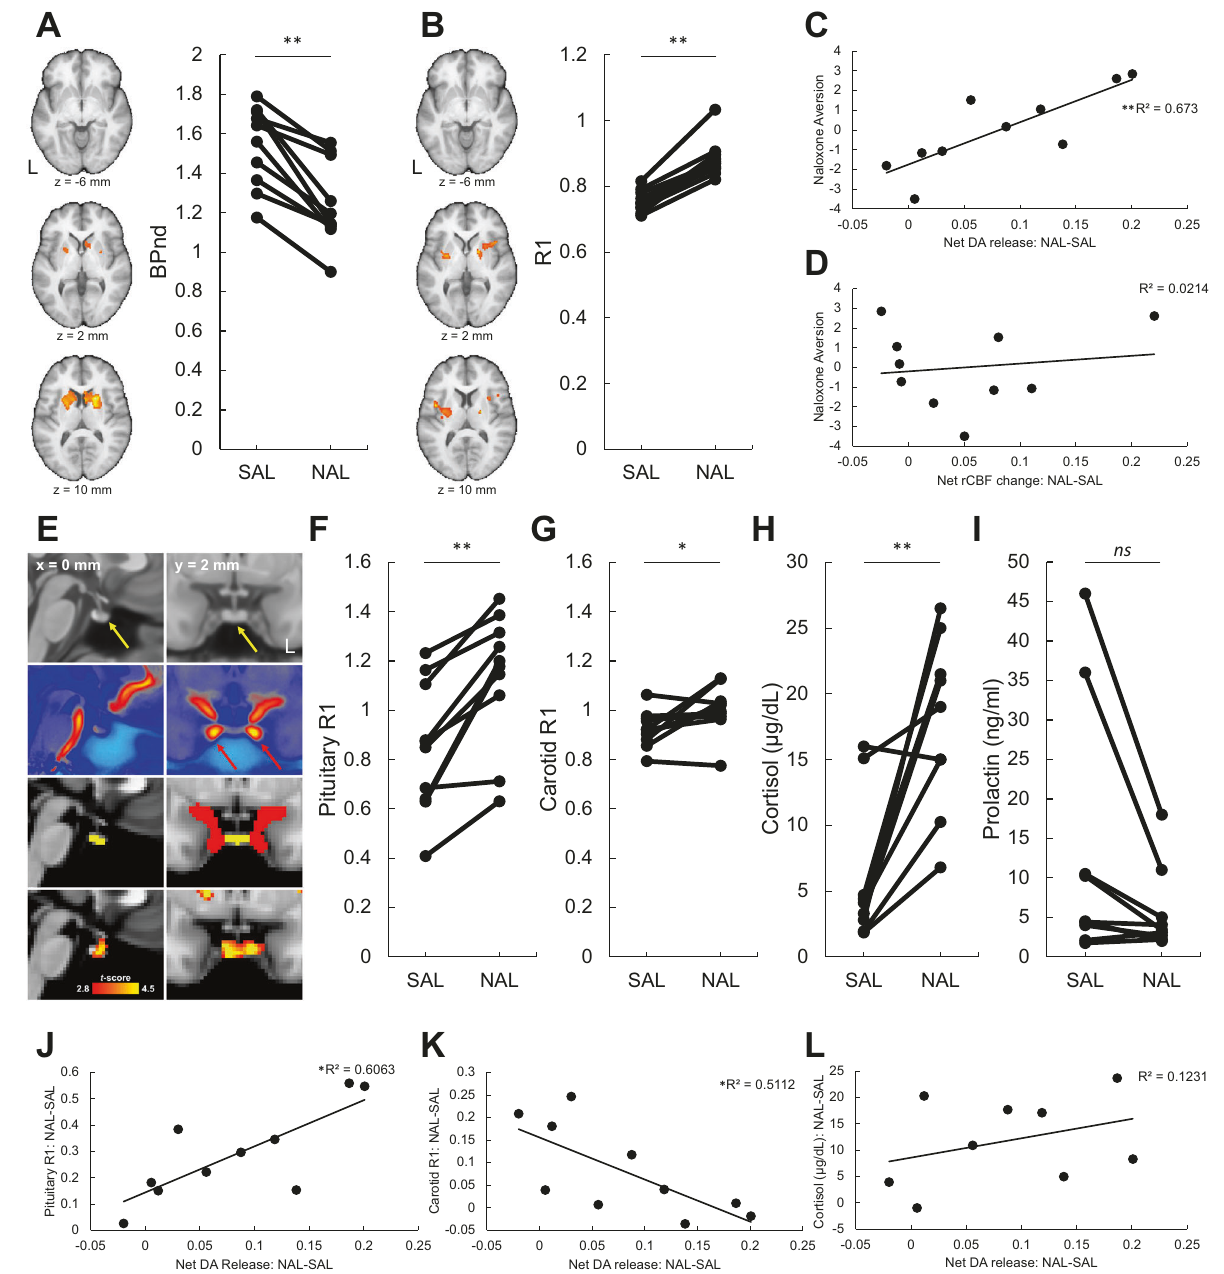
Fig. 1 Naloxone precipitated withdrawal affects dopamine release and relative cerebral blood fl ow in OUD men. A Voxelwise t -test on [ 11 C]racloprideBPnd revealed consistent decreases in NAL compared to SAL ( p FWE < 0.05). B Increases in R1 (a surrogate for rCBF) in the NAL compared to SAL ( p FWE < 0.05). C , D Index of naloxone aversion (higher component scores indicate more aversion) was signi fi cantly associated with net increases in striatal DA-release but not with net increases in striatal rCBF (see the “ Methods ” section). E Left and right columns show sagittal and axial views of the human brain. First row: T1w map of human brain (0.5-mm isotropic). The yellow arrows point at the pituitary. Second row: magnetic resonance angiography map of human brain (0.5-mm isotropic) [42]. The red arrows point at the internal carotid arteries. Third row: pituitary (yellow) and internal carotid arteries (red) ROIs. Fourth row: map of t -scores for the effect of NPW on R1 (cluster size > 200 voxels). F Increases in pituitary R1 across participants with NAL compared to SAL. G Increases in carotid R1 with NAL compared to SAL. H Increases in plasma cortisol with NAL compared to SAL. I Changes in plasma prolactin with NAL compared to SAL. It was notable that the two OUD participants with hyperprolactinemia showed a large reduction in prolactin with NAL compared to SAL. J Association between net striatal DA-release and increase in pituitary R1. K Association between net striatal DA-release and increase in carotid artery R1. L Association between net striatal DA-release and increase in plasma cortisol level. * p < 0.05, ** p < 0.005. ROI (SAL BPnd: 1.93 ± 0.27, NAL BPnd: 1.73 ± 0.23, p = 0.005) The net increase in striatal DA release (averaged throughout the whereas no signi fi cant change in BPnd was found in the ventral striatum, see the “ Methods ” section) was also signi fi cant during striatal ROI (SAL BPnd: 1.47 ± 0.26, NAL BPnd: 1.46 ± 0.28, p = 0.79). NPW ( p = 0.009, Cohen ’ s d = 1.05). Follow-up ROI analyses showed NPW-induced decreases in BPnd in the dorsal striatal ROI were signi fi cant NPW-induced decreases in BPnd in the dorsal striatal Translational Psychiatry (2021)